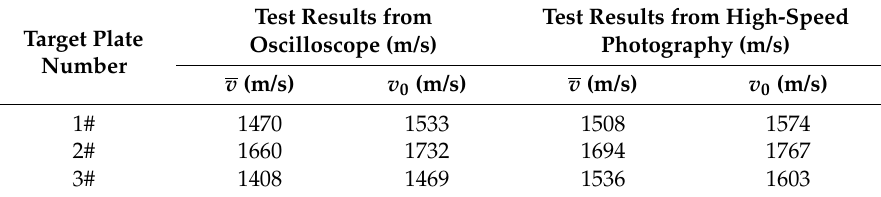
Table 7. Fragment velocity corresponding to the D-120 ◦